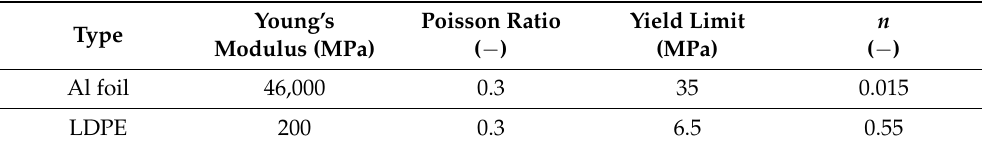
Table 1. Mechanical properties of Al foil and LDPE.